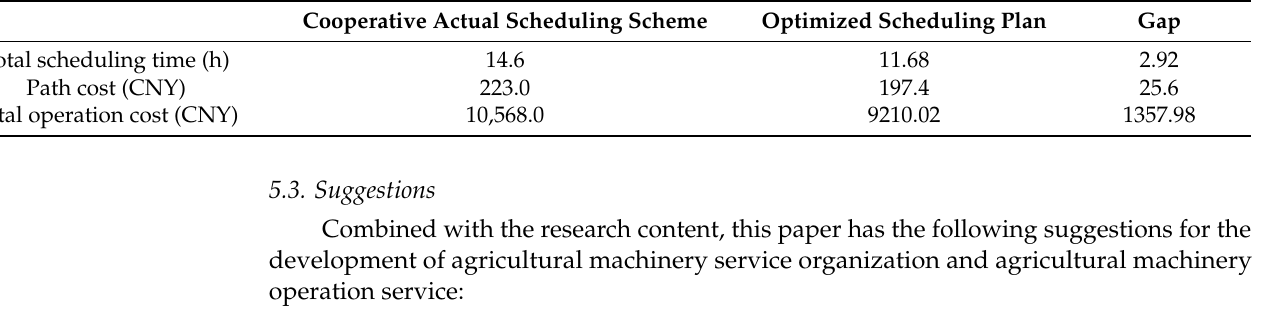
Figure 11. Visualization of the optimized scheduling. Table 9. Comparative analysis of the optimization results and the actual results.